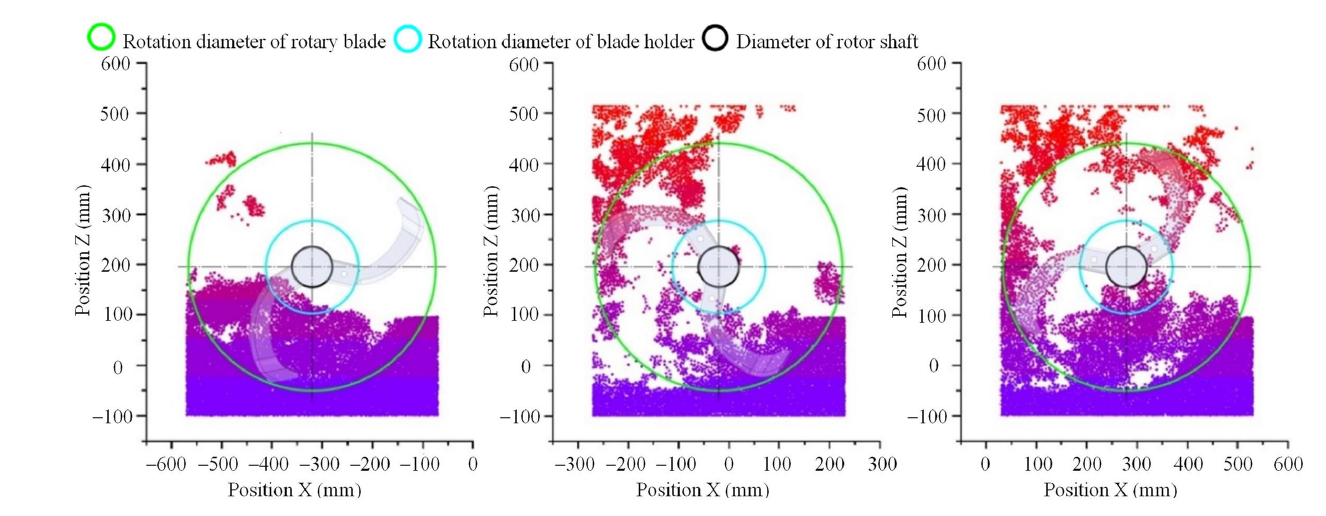
Figure 8. Rotary tillage unit soil particles distribution: ( a ) 0.2 s ( b ) 0.7 s ( c ) 1.2